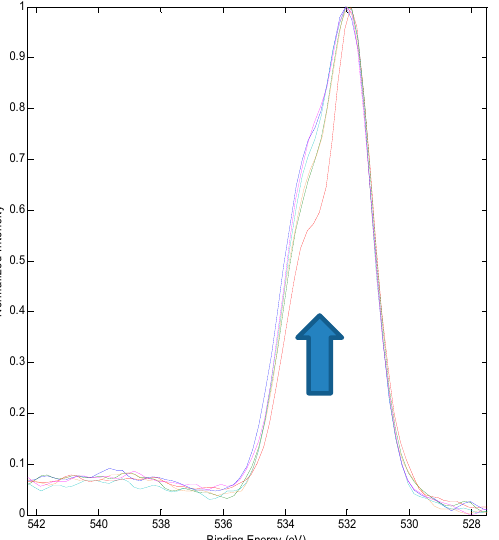
The changes in the O 1s spectra (Figure 5) confirmed the oxidation of the PES surface (Table 2).